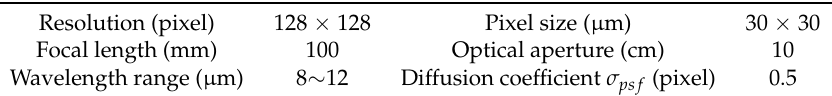
Table 1. Parameter setting of infrared (IR)